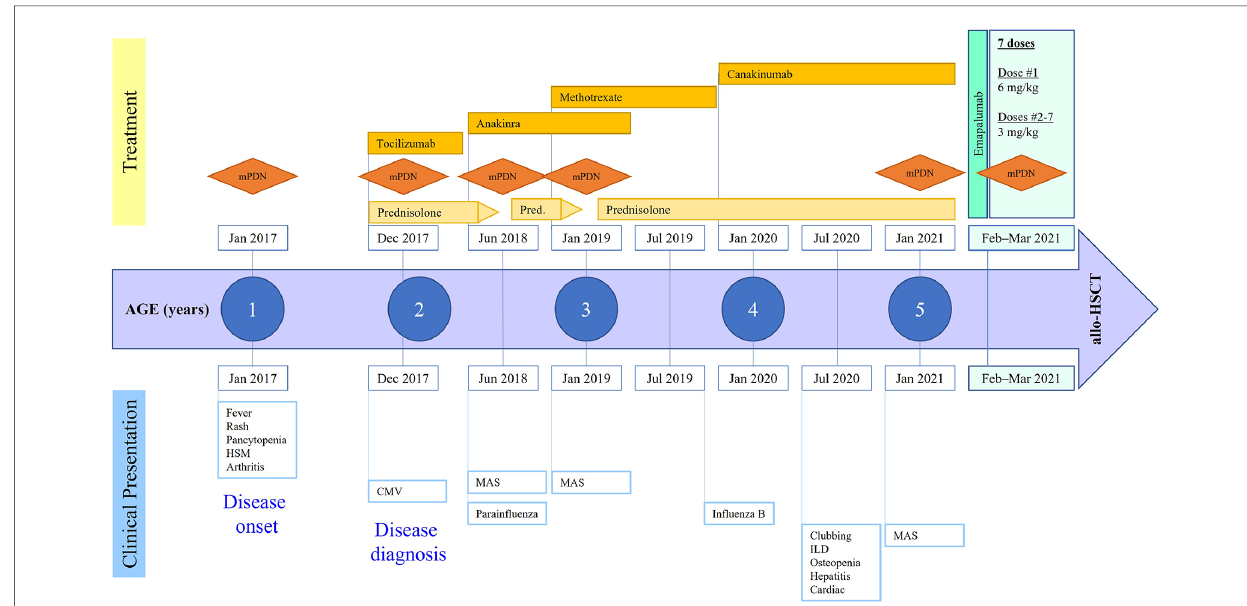
FIGURE 1 Disease course and treatment over time. mPDN, methylprednisolone; HSM, hepatosplenomegaly; CMV, cytomegalovirus; ILD, interstitial lung disease; MAS, macrophage activation syndrome; allo-HSCT, allogeneic hematopoietic stem cell